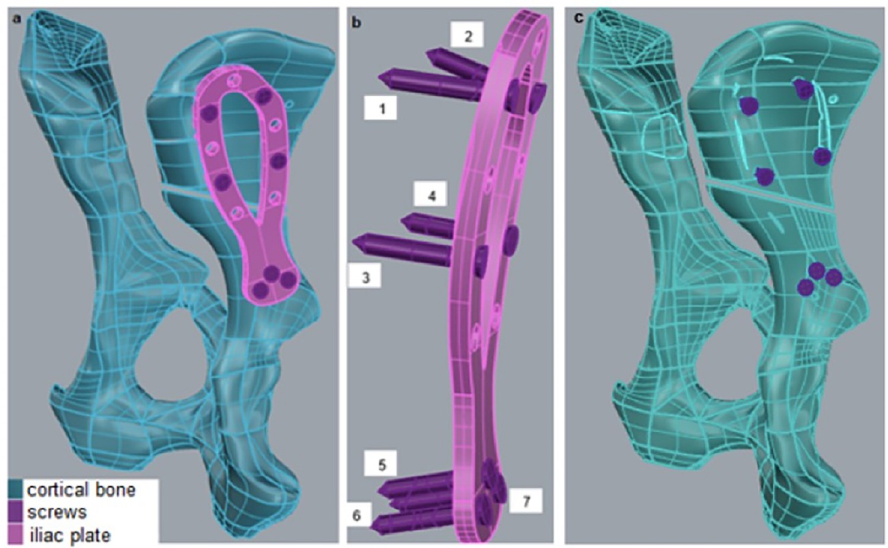
Fig 3. Lateral plate mounted on the osteotomized pelvis in tridimensional illustration (a). Detail of the screws inserted (b). Bone model illustration without the bone plate to denote the anatomical position of the osteotomy gap in relation to the body of the ilium